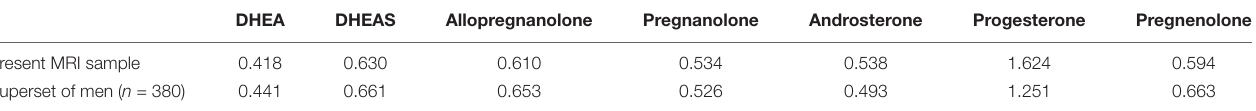
TABLE 8 | Coefficient of variability for neurosteroids in multiple samples. DHEA DHEAS Allopregnanolone Pregnanolone Androsterone Progesterone Pregnenolone Present MRI sample 0.418 0.630